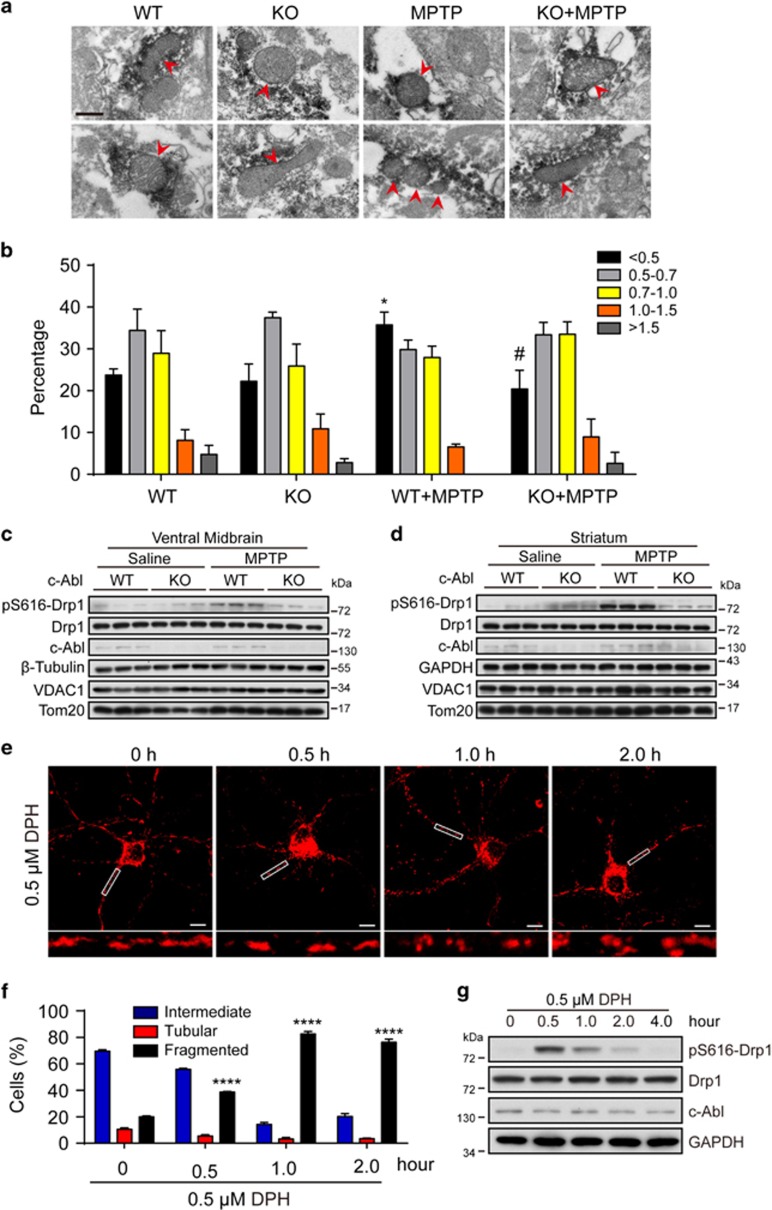
c-Abl is involved in the regulation of mitochondrial morphology in vivo. (a) WT and c-Abl KO littermate mice were treated with saline or MPTP (four i.p. injections of 20 mg/kg at 2 h intervals). At 2 h after total injections, immuno-EM was performed as described in Materials and Methods section. Two representative images (upper and lower) were picked for each group. Arrows indicate tyrosine hydroxylase-positive area containing mitochondria in SN. Scale bars, 0.5 μm. (b) Mitochondrial length was measured and divided into different categories of <0.5, 0.5–0.7, 0.7–1.0, 1.0–1.5 and >1.5 μm. Quantification of mitochondrial length is shown as percentages of total mitochondria (at least 50 mitochondria were measured per mouse). (two-way ANOVA, *P<0.05 compared with the WT group, #P<0.05 compared with the WT+MPTP group, n=3 mice.). (c) Striatal tissue or (d) ventral midbrain was collected from WT and c-Abl KO littermate mice 2 h after treatment with saline or MPTP and subjected to immunoblotting using the indicated antibodies. (e) Primary cortical neurons were immunostained with the anti-Tom20 antibody after 0.5 μM DPH treatment for 0, 0.5, 1 and 2 h, respectively, followed by confocal microscopy. Scale bars, 10 μm. (f) Quantification of mitochondrial morphology from panel (e). (two-way ANOVA, fragmented: ****P<0.0001, compared with 0 h group; n=3 slides). (g) Lysates of primary cortical neurons treated with 0.5 μM DPH for the indicated times were immunoblotted with the indicated antibodies